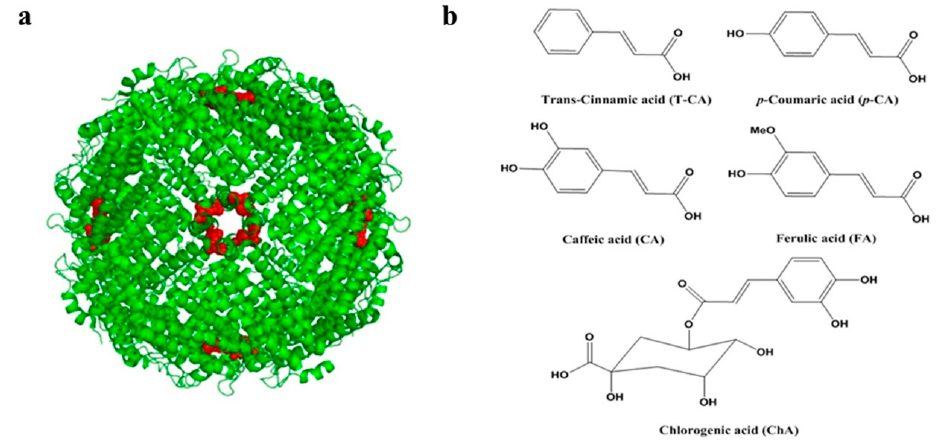
Figure 1. ( a ) Crystal structure of plant ferritin with views down the four-fold axes (channels) of the protein shell. The tryptophan residue of each subunit is highlighted in red; ( b ) Chemical structure of cinnamic acid derivatives: Trans -cinnamic acid (T-CA); p -Coumaric acid ( p -CA); Caffiec acid (CA); Ferulic acid (FA); Chlorogenic acid (ChA)